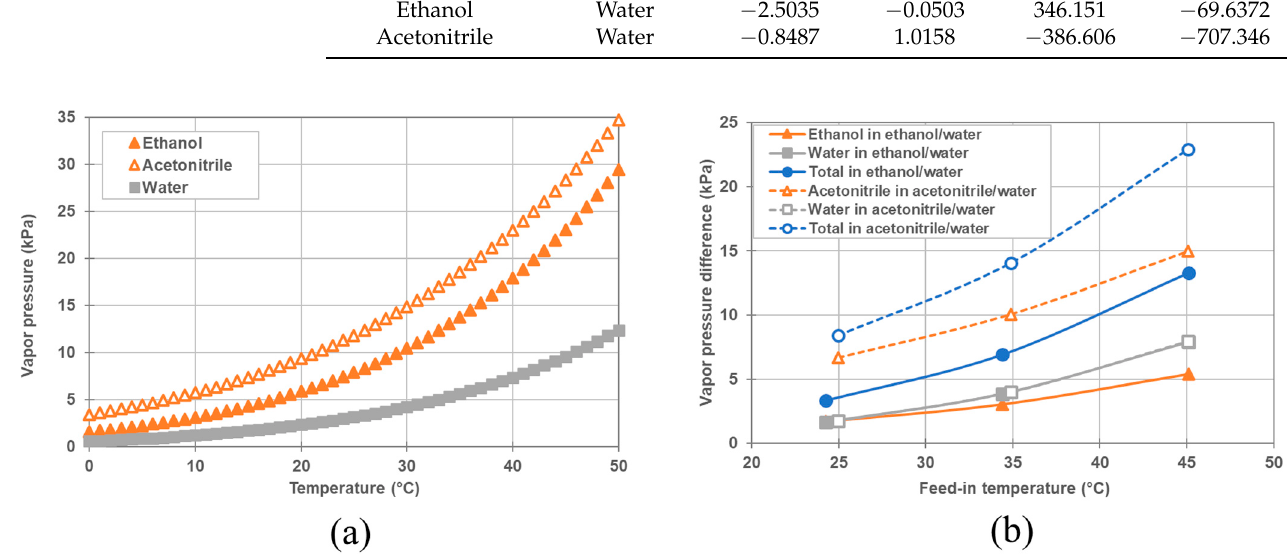
Figure 8. ( a ) Vapor pressure of acetonitrile, ethanol, water as a function of temperature. ( b ) Vapor pressure differences for